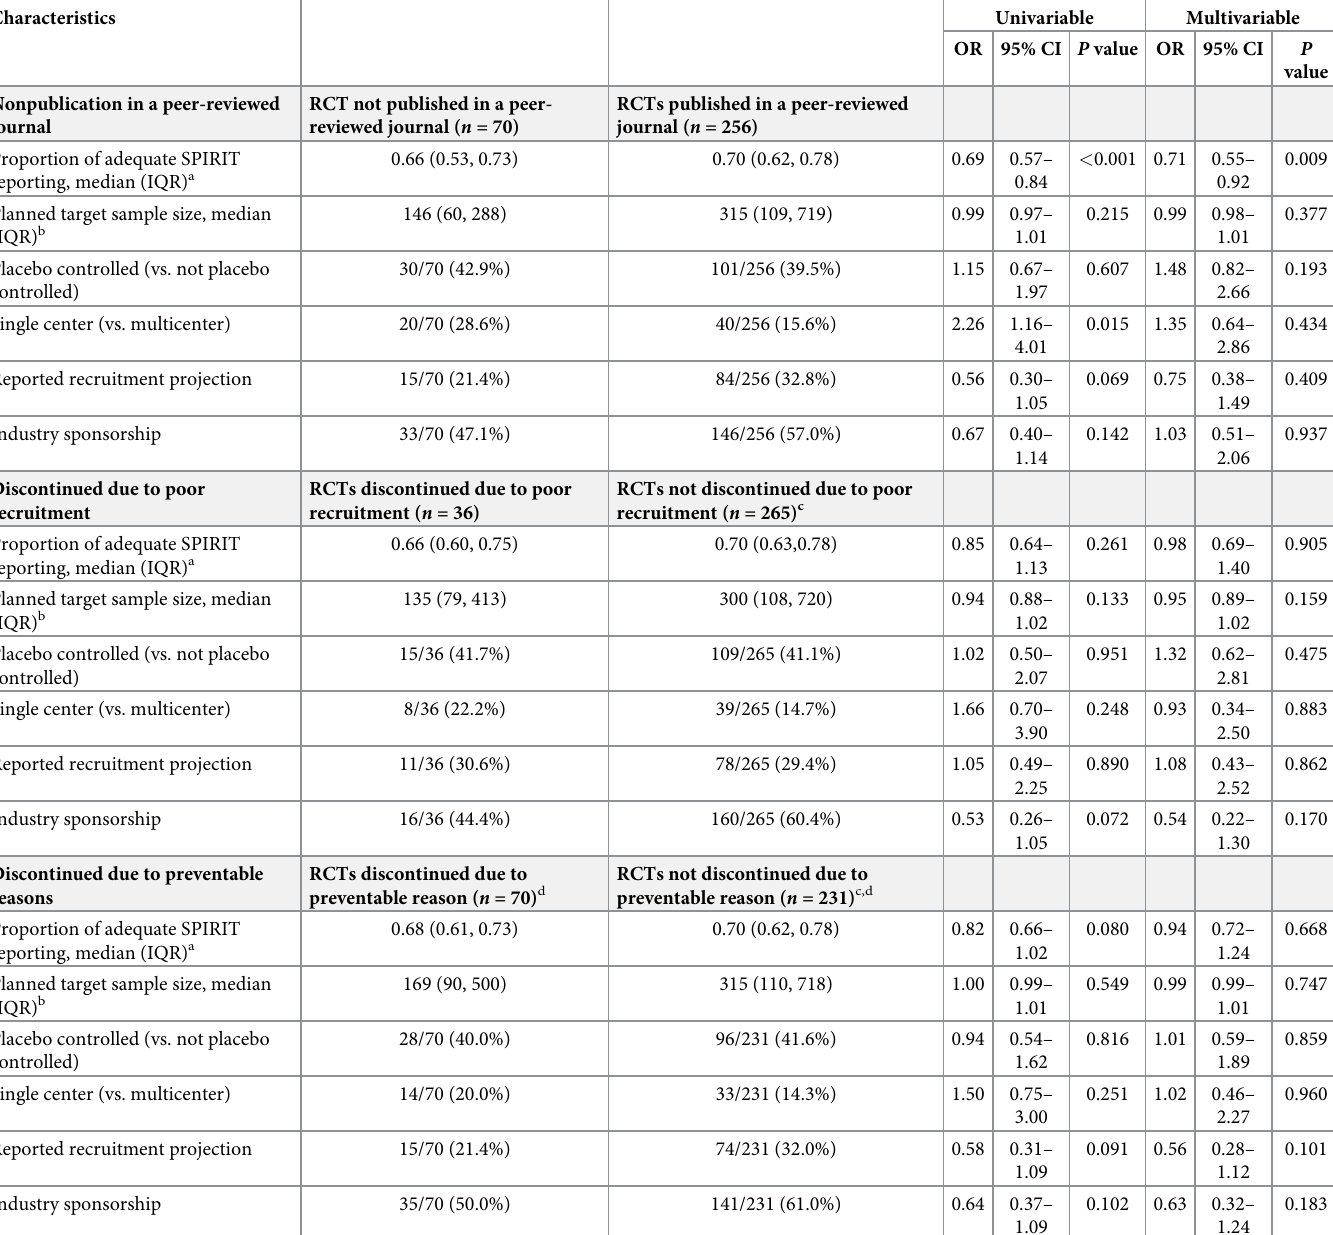
Table 4. Factors associated with (a) publishing main results in a peer-reviewed journal; (b) discontinuation of trials due to poor recruitment; and (c) discontinua- tion of trials due to preventable